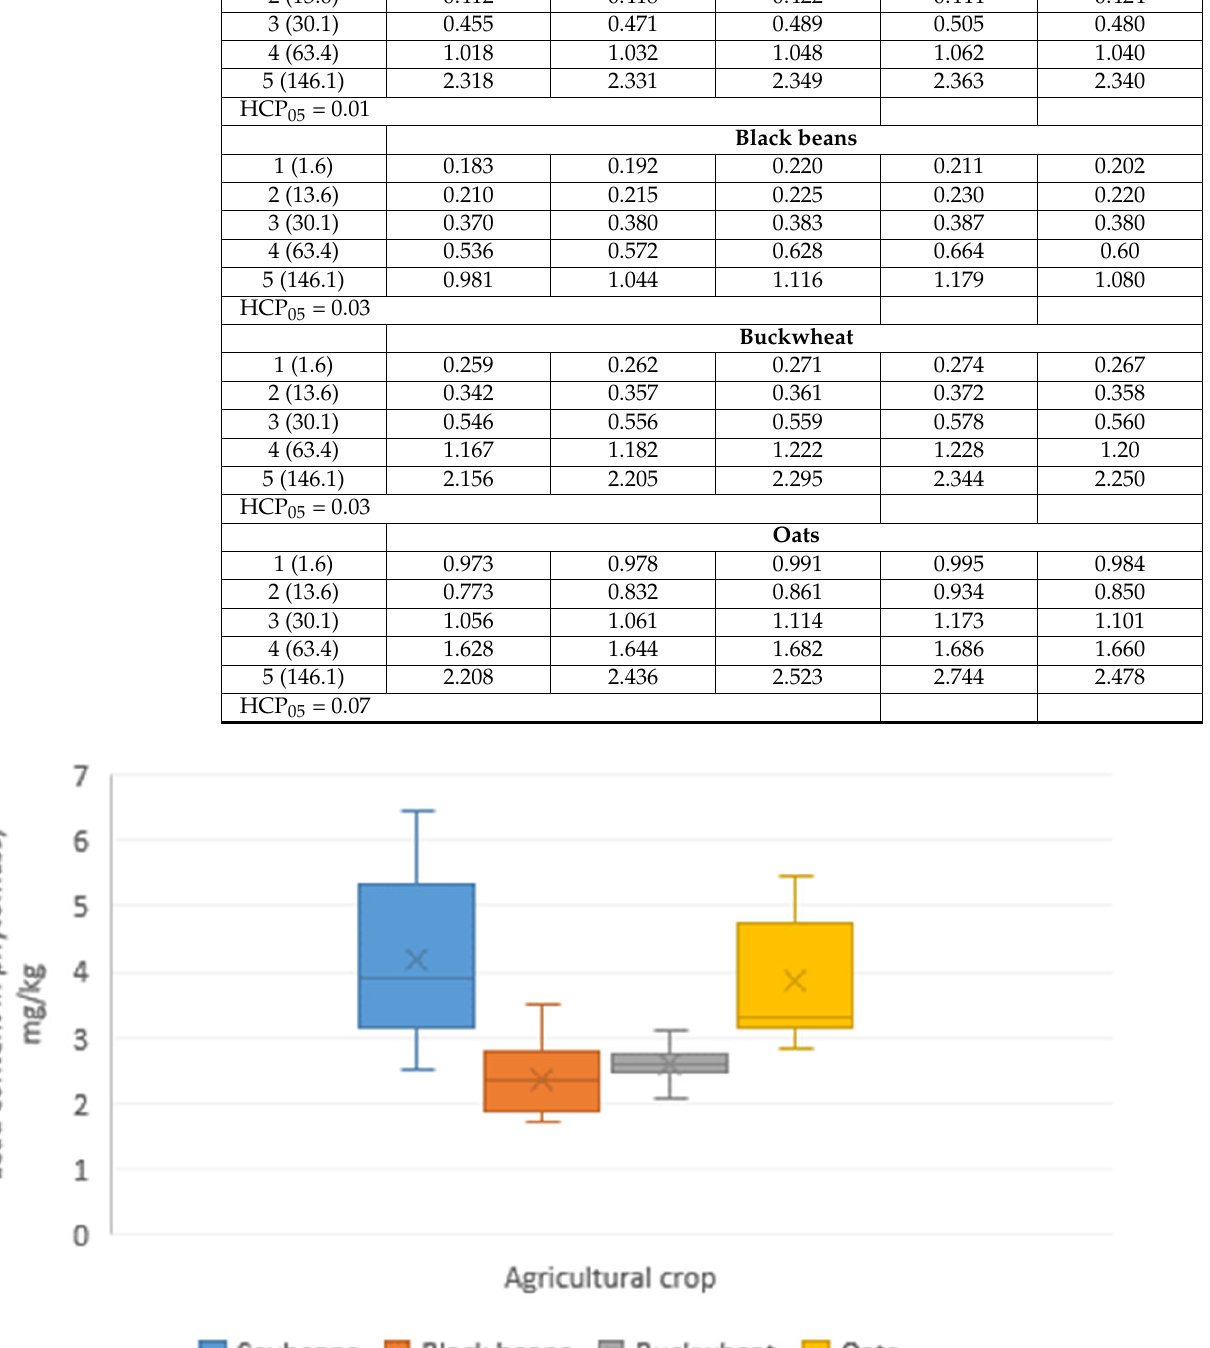
Figure 4. Diagram of cadmium content in the phytomass of test crops on the variants of the vegeta ‐ tion experiment depending on the values of the total indicator of soil contamination. Analysis of the results of determining the content of heavy metals in the phytomass of test crops (Tables 2–5) depending on the total index of soil contamination revealed a number of features. Thus, at permissible, moderately hazardous, and highly hazardous levels of soil contamination (variants 2–4) copper is more actively concentrated by phyto ‐ mass of beans and oats than by soybean and buckwheat, and at extremely hazardous lev ‐ els of pollution (option 5)—by the phytomass of beans, buckwheat, and oats than soybean. In variant 5, in comparison with variant 4, reduction of the copper content in the phyto ‐ mass of soybeans, beans and oats is noted. It was established that at permissible and moderately dangerous levels of soil pollu ‐ tion (variants 2–3) zinc is more actively concentrated by the phytomass of oats and beans than by soybean and buckwheat, but at highly and extremely dangerous levels of pollu ‐ tion (variants 4 and 5) zinc is concentrated by phytomass of oats and soybean than by bean and buckwheat. At the same time, on all test crops, an increase of zinc content in the phy ‐ tomass of plants with an increase in the value of the total index of soil contamination is noted. The investigations show that from the permissible to extremely dangerous levels of soil pollution (variants 2–5) lead is more actively concentrated in the phytomass of soy ‐